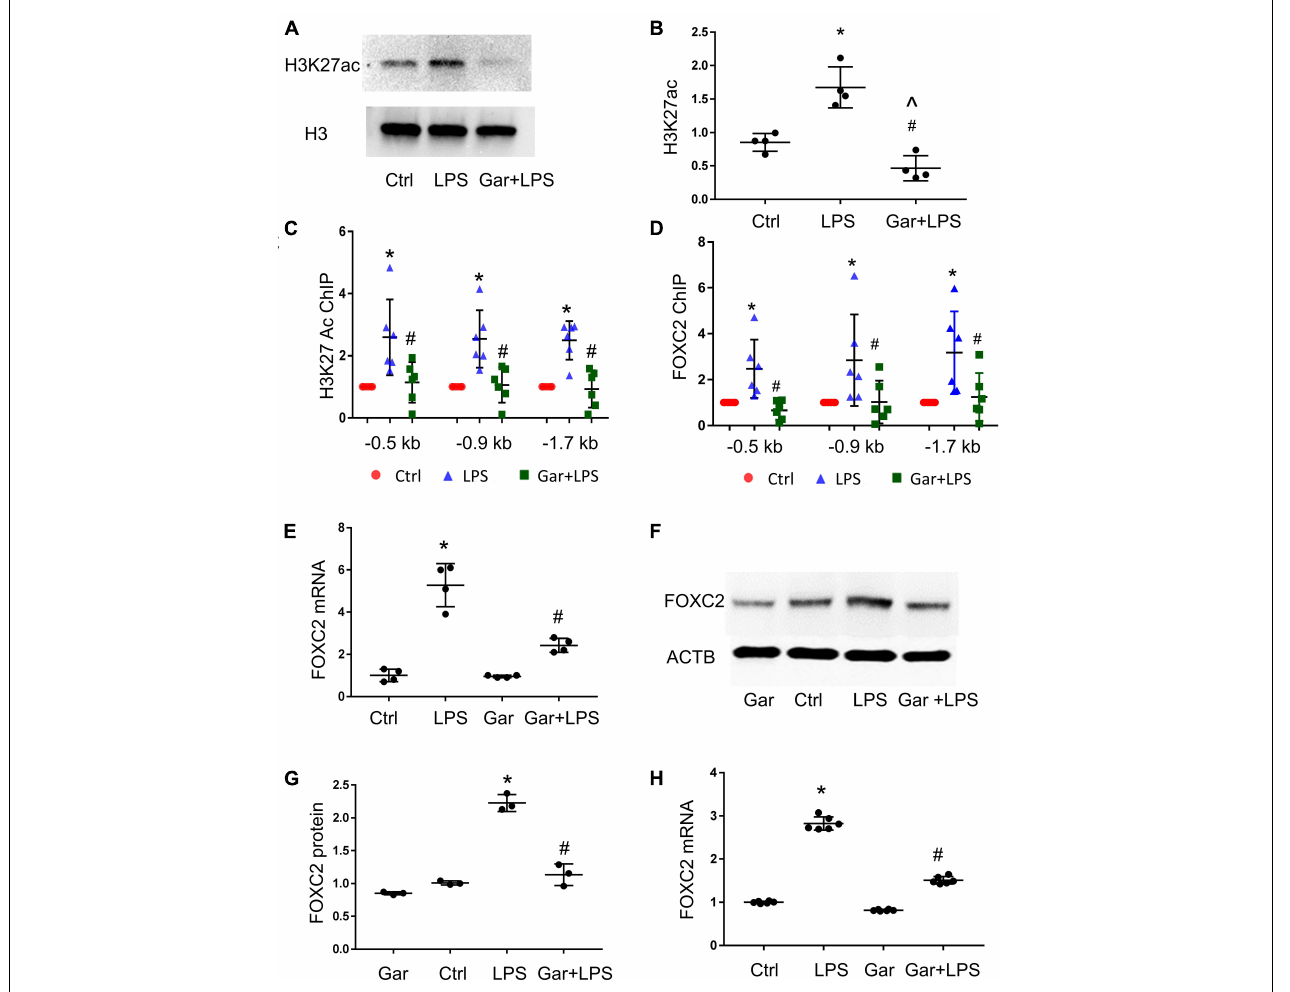
FIGURE 3 | LPS enhances FOXC2 expression by stimulating histone acetylation and FOXC2 binding affinity in HPMEC. (A) Acetylated H3K27 (H3K27ac) protein was quantified by immunoblotting from HPMEC-Im cell lysates 30 min after LPS with or without Garcinol (Gar) pretreatment, with densitometry shown graphically (B) . n = 4 per group; * p < 0.05, LPS vs. Ctrl; # p < 0.05, LPS + Gar vs. LPS, ˆ p < 0.05, LPS + Gar vs. Ctrl. (C) ChIP with anti-acetylated H3K27 antibody was performed at 30 min after LPS treated HPMEC-Im, with or without garcinol pretreatment. n = 6 per group; * P < 0.01, LPS vs. ctrl; # p < 0.05, LPS + Gar vs. LPS. (D) ChIP with anti-FOXC2 antibody was performed 30 min after LPS treated HPMEC-Im, with or without garcinol pretreatment. n = 6 per group; * P < 0.05, LPS vs. ctrl; # p < 0.05, LPS + Gar vs. LPS. (E) FOXC2 mRNA was quantified by qRT-PCR 4 h after LPS treated HMPEC-Im, with or without garcinol pretreatment. n = 4 per group; * P < 0.01, LPS vs. ctrl; # P < 0.05, LPS + Gar vs. LPS. (F) FOXC2 protein was quantified by immunoblotting after 16 h LPS treated HPMEC-Im, with or without garcinol pretreatment, with densitometry shown graphically (G) . n = 3 per group; * p < 0.005, LPS vs. ctrl; # p < 0.001, LPS + Gar vs. LPS. (H)